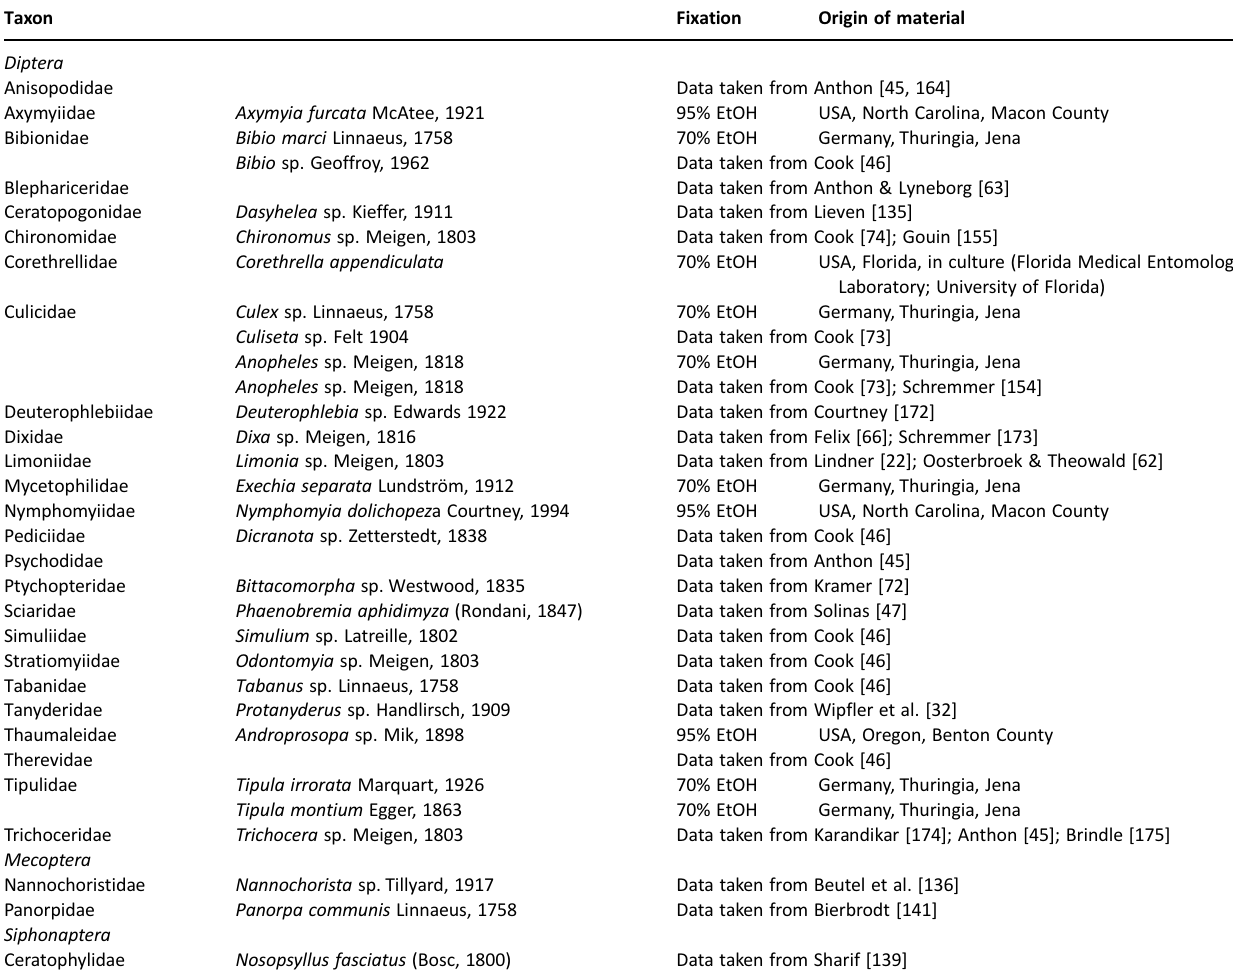
Table 2 . List of larval taxa